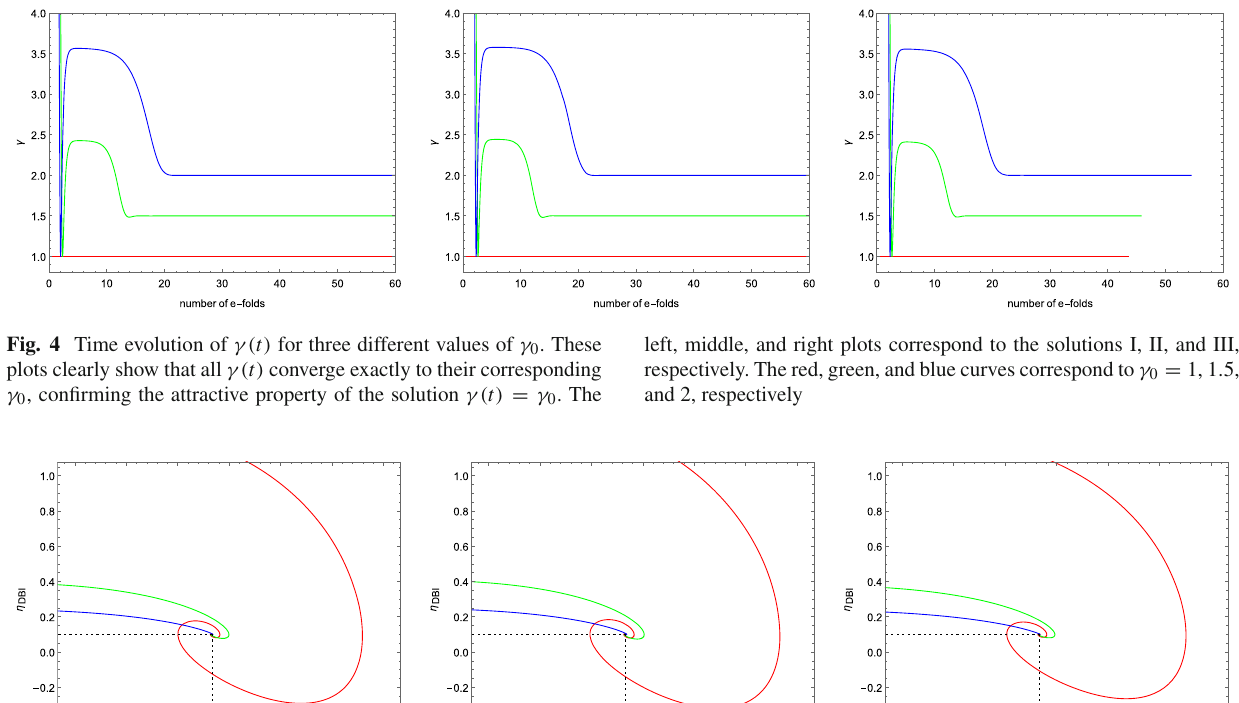
the attractive property of the solution n = ˆ β/ 6. The left, middle, and rightplotscorrespondtothesolutionsI,II,andIII,respectively.Thered, green, and blue curves correspond to γ 0 = 1, 1 . 5, and 2, respectively